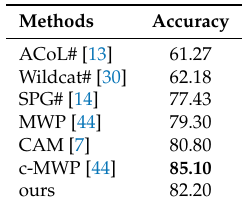
Figure 6. Visualization results for the VOC2007 test set. ( a ) Attention maps, ( b ) pointing detection results, and ( c ) bounding box detection results. Table 4. Pointing localization accuracy (%) on the VOC2007 test